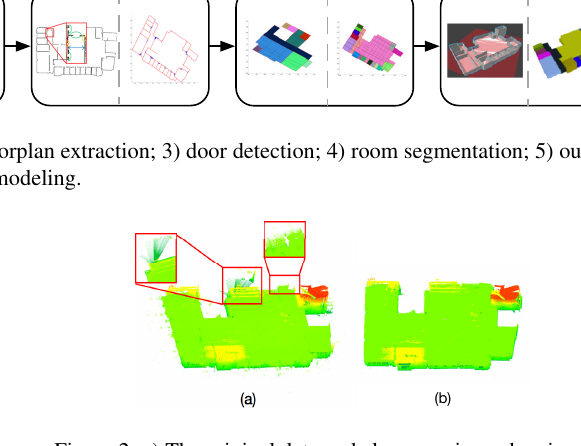
Figure 2. a) The original data and close-up views showing the doors; b) The result after the preprocessing step.